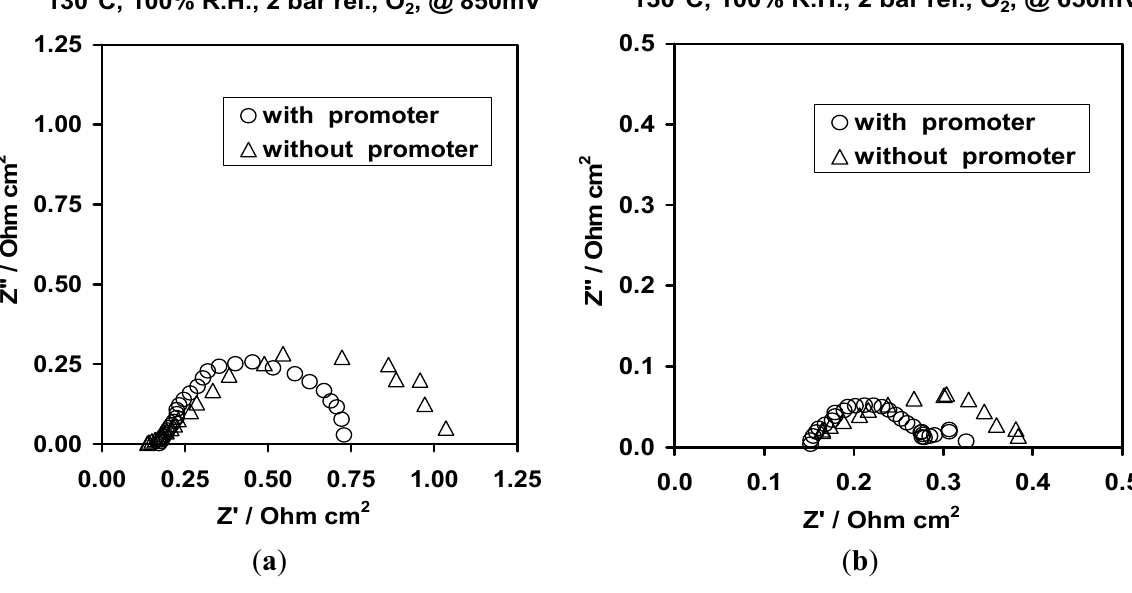
Figure 6. AC impedance spectra for the promoter-based and the bare membrane electrode assemblies (MEAs) at 130 °C, 100% R.H., O 2 feed, 2 bar rel., at a cell voltage of: ( a ) 0.85 V; ( b ) 0.65